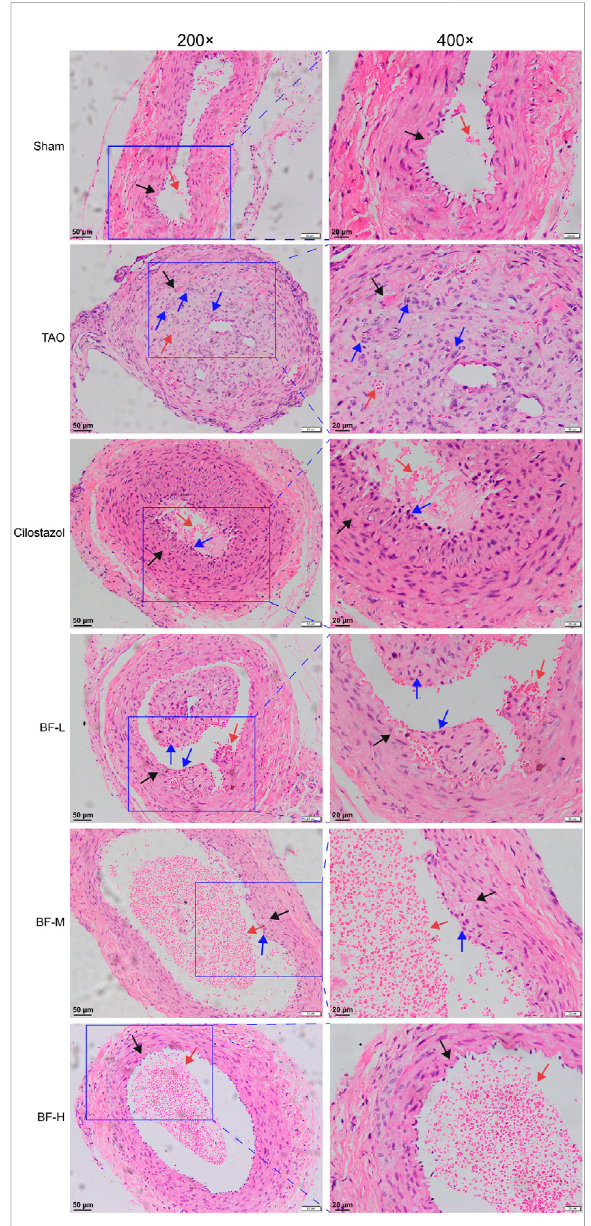
FIGURE 4 H&Estainingofratfemoralartery.Blackarrow:femoralartery intima; Red arrow: erythrocytes; Blue arrow: leukocytes. Sham: sham-operated group; TAO: TAO model group; Cilostazol: cilostazol group; BF-L: BF low-dose group; BF-M: BF medium-dose group; BF-H: BF high-dose